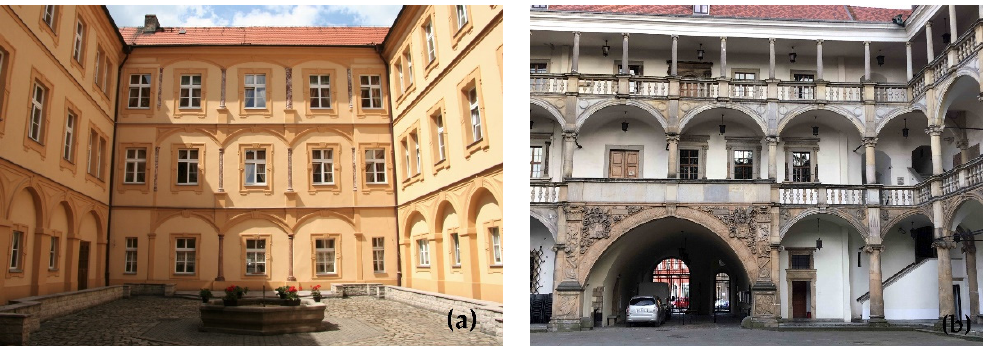
Figure 20. ( a ) Prószków castle: courtyard, loggia; photo by the authors; ( b ) Brzeg castle: courtyard, open gallery; photo by the authors.